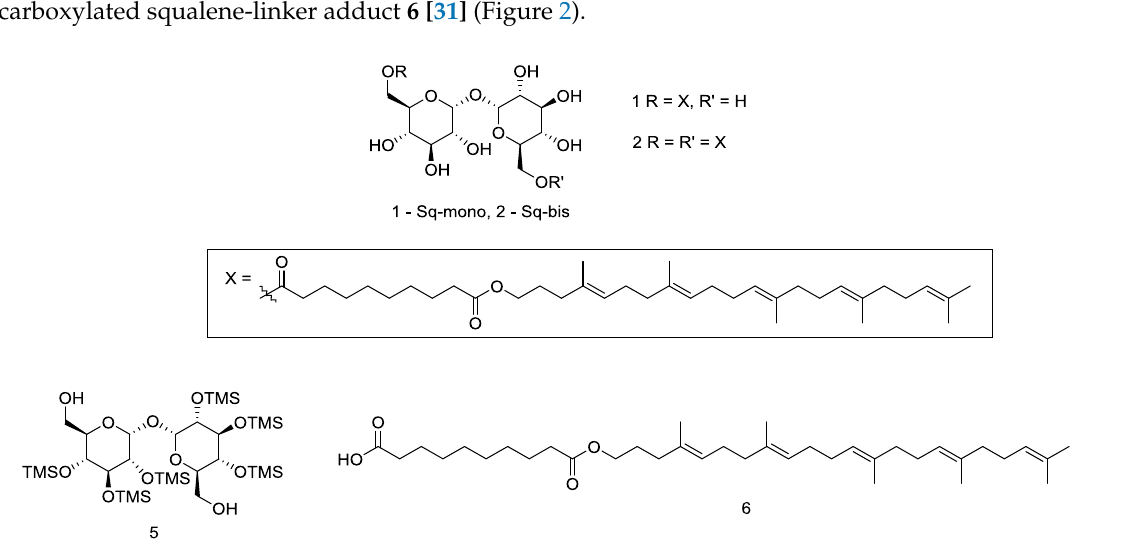
Figure 2. Chemical structure of target squalene-trehalose conjugates 1-Sq-mono and 2-Sq-bis , and of key synthetic intermediate hexaTMS-protected trehalose 5 and carboxylated squalene-linker adduct